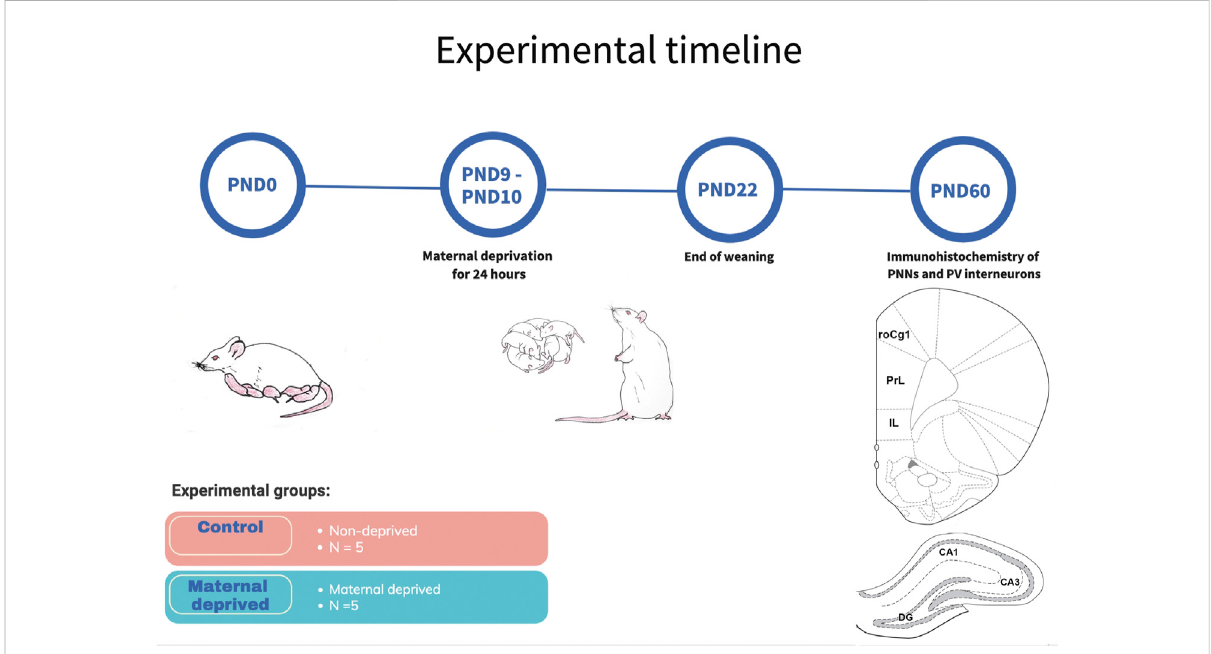
Schematicrepresentationofexperimentaltimeline.OnPND9,damshavebeenremovedfrompupsfor24 h,andbroughtbackuntilweaningon PND22. Brains from young adult males from three differend litters were used for immunohistochemical analysis of PNNs and PV + interneurons in three regions of the medial prefrontal cortex and three regions of the dorsal hippocampus. Hippocampal sub fi elds CA1 (CA1) and CA3 (CA3), rostral part of the area one of the cingulate cortex (roCg1), dentate gyrus (DG), infralimbic cortex (IL), maternally deprived rats (MD), medial prefrontal cortex (mPFC), prelimbic cortex (PrL), postnatal day